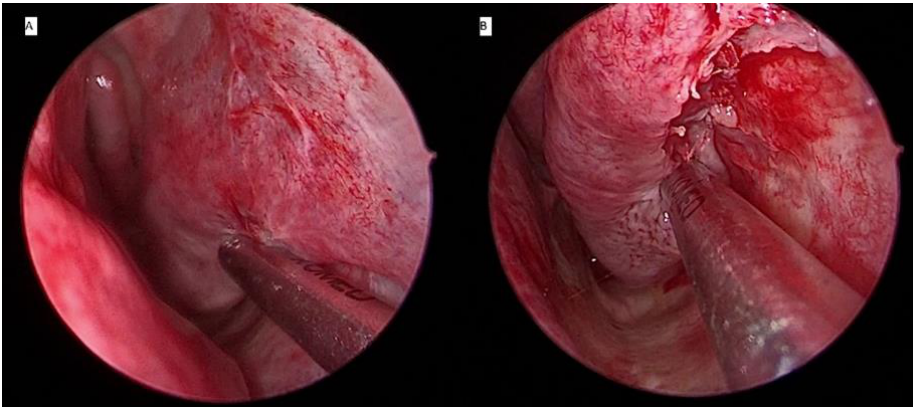
Figure 3. Microdebrider blade is placed at the lateral part of the left turbinate to dissect the lateral mucosal wall and turbinate bone from anterior ( A ) to posterior ( B ) direction.